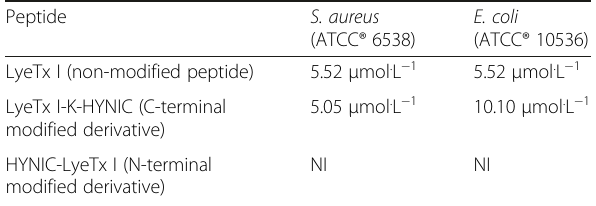
Table 2 Minimum inhibitory concentration (MIC) of LyeTx I (control), LyeTx I-K-HYNIC and HYNIC-LyeTx I against S. aureus and E. coli in TSB